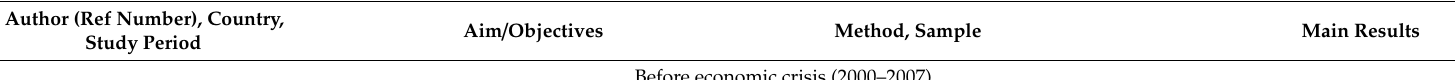
Table 2. Main features and results of the 19 cross-sectional quantitative studies included in the scoping review about occupational health and safety of immigrant workers in Italy and Spain